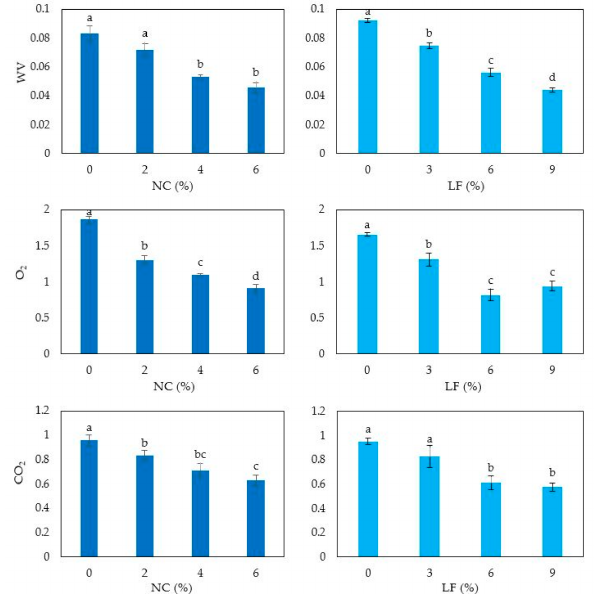
Figure 7. Gas and water vapor permeability of hemp protein-based films prepared with film forming solutions containing increasing amounts of either nanocrystalline cellulose (NC) or lignin fraction (LF) and prepared at pH 9 and 12, respectively. Di ff erent small letters a–d indicate significant di ff erences among the values reported in each column ( p < 0.05). Further experimental details are given in